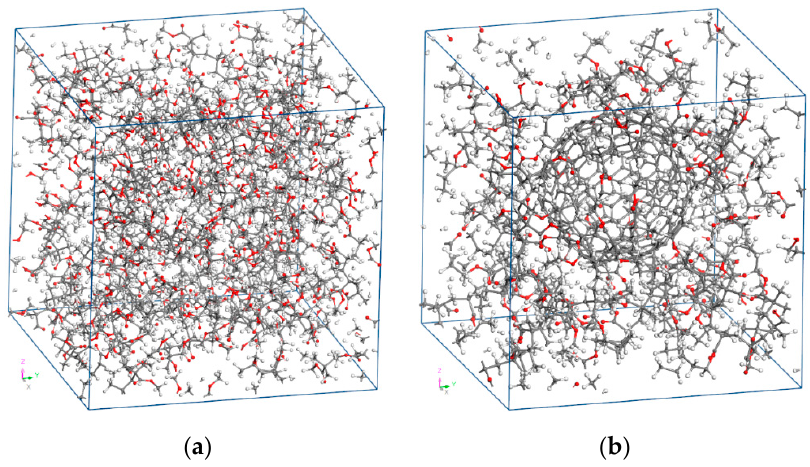
Figure 3. Equilibrated unit cell at the temperature T = 300 K of the ( a ) pure PMMA and ( b ) fullerene-reinforced PMMA at a mass fraction of w C240 = 0.2.